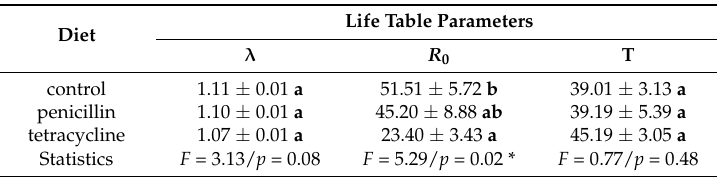
Table 3. Life table parameters of the coffee berry borer Hypothenemus hampei reared in artificial diet with and without antibiotics. Life Table Parameters Diet